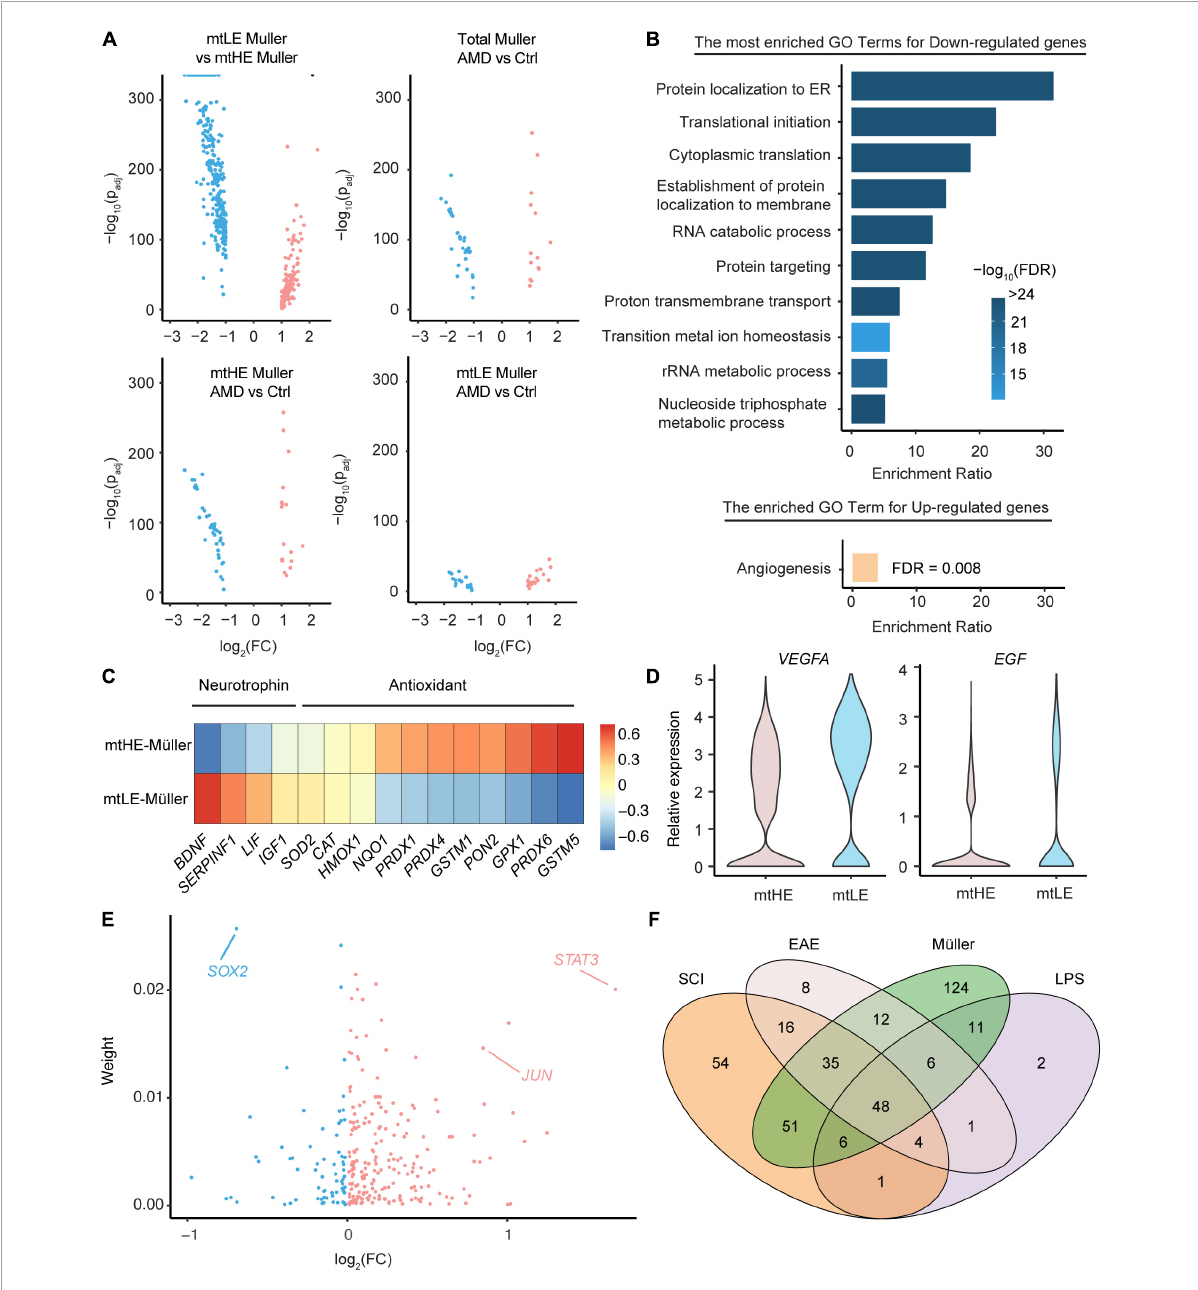
FIGURE3 The functional diversity and regulatory networks of Müller cells with distinct metabolic-mitochondrial signatures. (A) The differential expression analysis enriched key DEGs under four comparison conditions. (B) The go-term analysis highlights the repressed protein synthesis in low expression of mtDNA (mtLE) Müller cells. Only the DEGs enriched by the comparison between mtLE and mtHE subpopulations [shown in the upper-left part of panel (A) ] are processed in this analysis. (C) The mtLE Müller cells produce less antioxidant but more neurotrophin, compared with high expression of mtDNA (mtHE) subpopulation. (D) The expressions of VEGFA and EGF are upregulated in mtLE Müller cells. (E) The regulatory TFs controlling the expression profiles of mtLE and mtHE Müller cells are predicted. “Weight” indicates the estimated contribution of each TF and the x -axis is the fold change between mtLE and mtHE subpopulations. (F) The overlapping of regulators enriched from Müller cells and astrocytes under different conditions. SCI, spinal cord injury; EAE, experimental autoimmune encephalomyelitis; LPS,